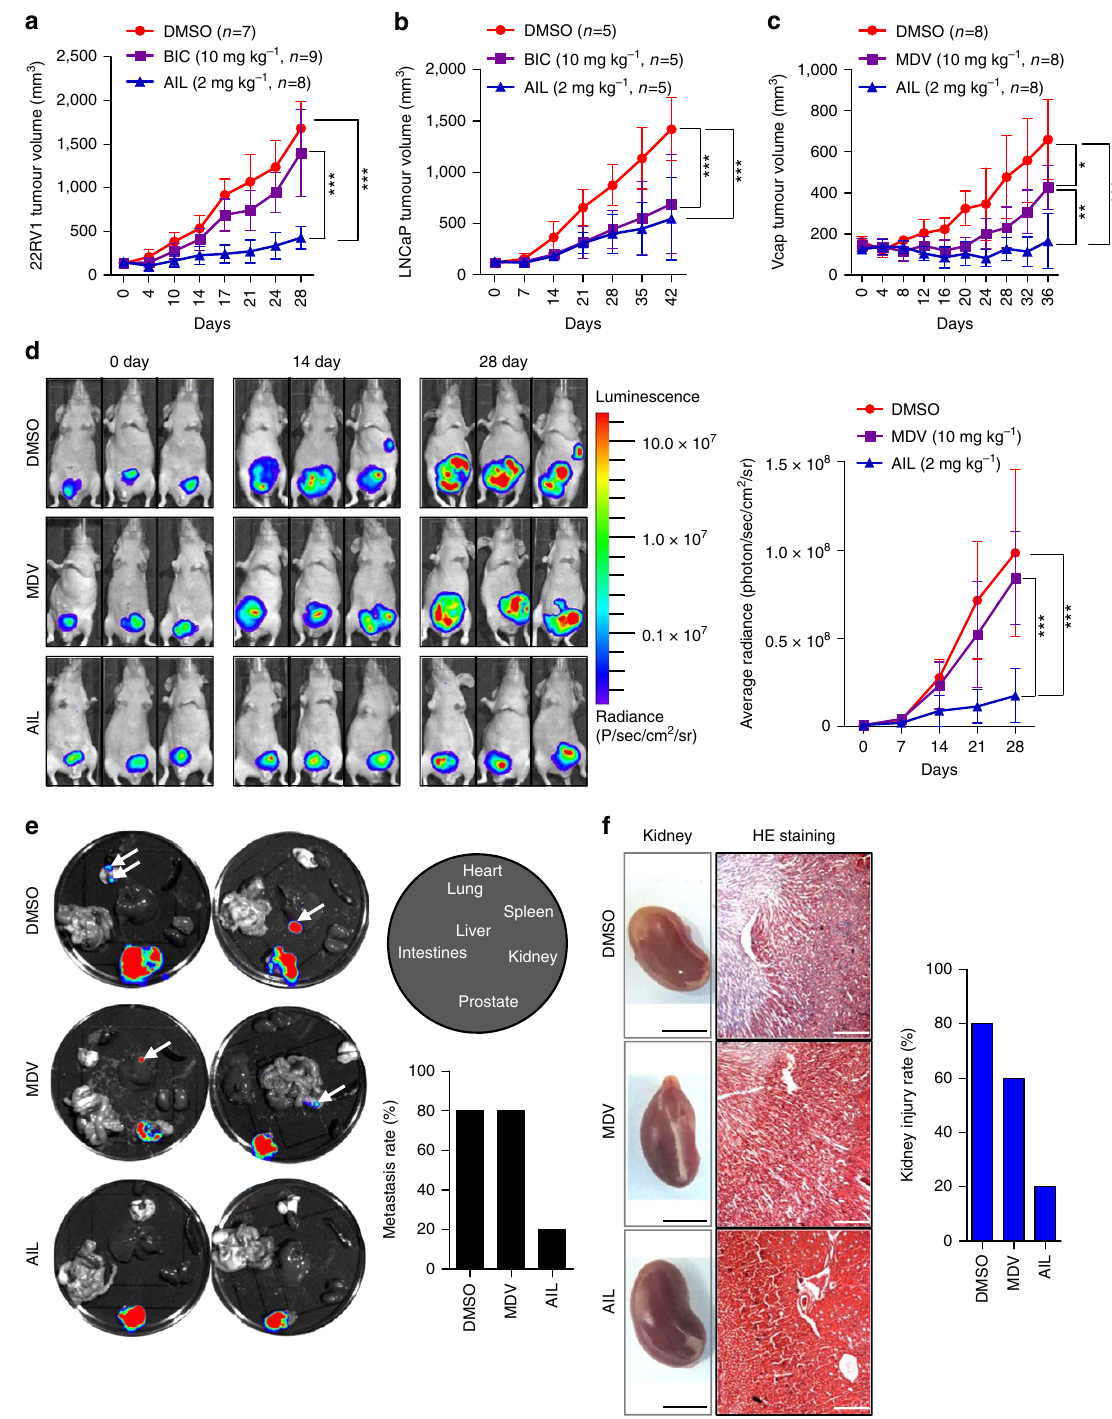
Figure 2 | Therapeutic effects of AIL on castration-resistant xenografts. ( a – c ) 22RV1 ( a ), LNCaP ( b ) and VCaP ( c ) cells suspended in 0.1ml PBS (22RV1) or matrigel (LNCaP, VCaP) were injected into the right flank of BALB/c-nude mice. Androgen containing blocks were subcutaneously inserted into each mouse in the LNCaP and VCaP xenograft models. After the volume of tumour nodules reached about 100mm 3 , the mice were randomly assigned to the indicated groups and respectively i.p. injected with vehicle control, AIL, BIC or MDV as indicated. The control group was injected with DMSO. Tumour volume and the mouse body weight were measured twice per week. ( d ) Male BALB/c-nude mice were anaesthetized, and the dorsolateral prostate was injected with 22RV1-luc cells in matrigel. After a week, mice were castrated and treated i.p. with DMSO, 10mgkg (cid:2) 1 MDV or 2mgkg (cid:2) 1 AIL once per day. Tumours were imaged every week to determine local tumour growth and evidence of tumour cell dissemination. Representative images of three mice per group were illustrated ( n ¼ 5). ( e ) After 28 days, mice were killed and local tumours and viscera of the mice were imaged to determine tumour growth and evidence of tumour cell dissemination. Representative images of the dishes are shown, and the number of mice which had metastatic tumours was counted ( n ¼ 5). ( f ) The mouse kidneys from the same experiment as d were histopathologically evaluated. The number of mice that had kidney injury was counted ( n ¼ 5). Scale bars: the black scale bar is 0.5cm (left) and the white scale bar is 100 m m (right). Data represent the mean ± s.d. * P o 0.05, ** P o 0.01, *** P o 0.001 by one-way ANOVA followed by Bonferroni multiple comparison